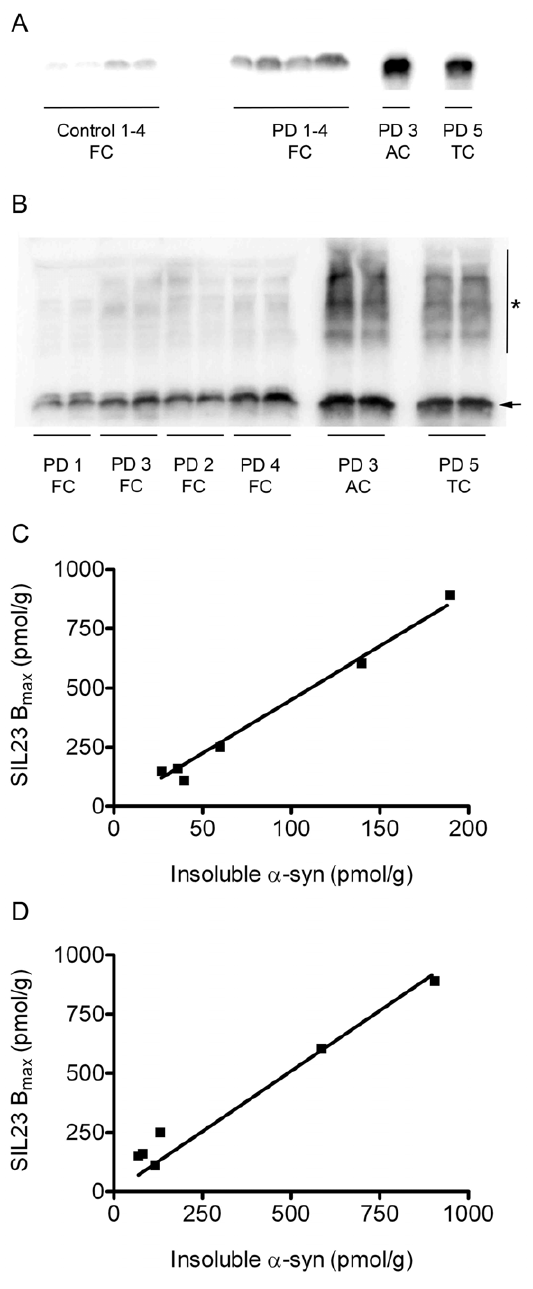
Figure 6. Binding of [ 125 I]SIL23 is correlated with levels of insoluble a -syn present in PD brain. Levels of a -syn were measured in insoluble fractions from human brain samples (n=10) by sequential extraction and western blot. A representative syn1 western blot with SDS extracts from PD and control cases is shown in A . A quantitative syn303 western blot with SDS extracts from PD cases is shown in B , in which higher molecular weight a -syn species (asterisk) are observed in combination with monomeric a -syn (arrow). The correlation of B max values for [ 125 I]SIL23 binding to levels of total insoluble a -syn quantified from the monomer band on western blot is shown in C . The correlation of B max values for [ 125 I]SIL23 binding to levels of total insoluble a -syn quantified from monomer plus high molecular weight species on western blot is shown in D . Results were verified with more than three independent experiments.